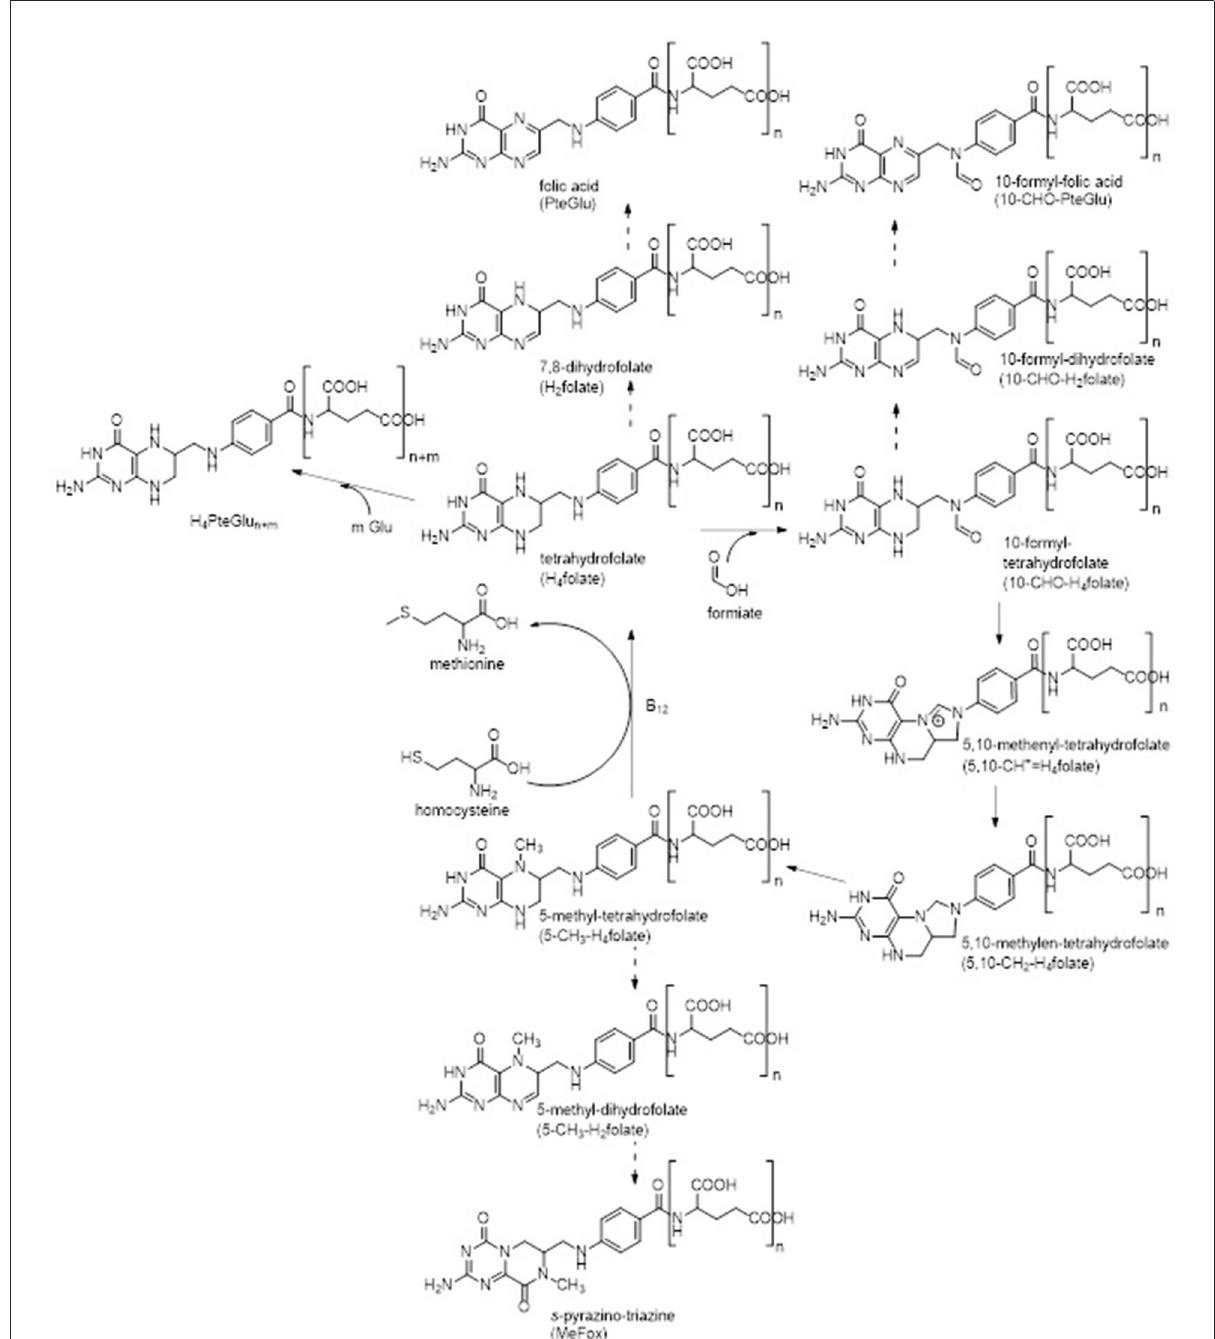
FIGURE1 C 1 -metabolism of folate vitamers known so far. Common oxidation reactions (dashed arrows) were incorporated into the figure as well as enzymatic polyglutamylation. Enzymes participated in interconversion reactions are not stated for the sake of clarity.